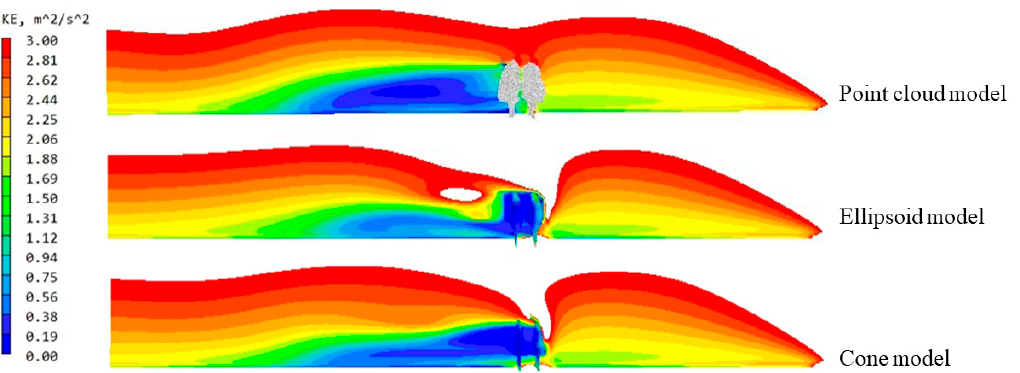
Figure 11. Cloud map of turbulent kinetic energy distribution for three canopy models. The turbu- lence distribution characteristics around the protective forest at different heights represent different turbulence intensities (0, 1, 2, and 3 m 2 /s 2 ), and the blue, green, and yellow areas represent the turbulence distribution characteristics at different heights; the blue area has the weakest turbulence intensity. The intensity of the yellow region ranges from 2 < KE < 3; green for 1 < KE < 2; and blue for 0 < KE < 1.